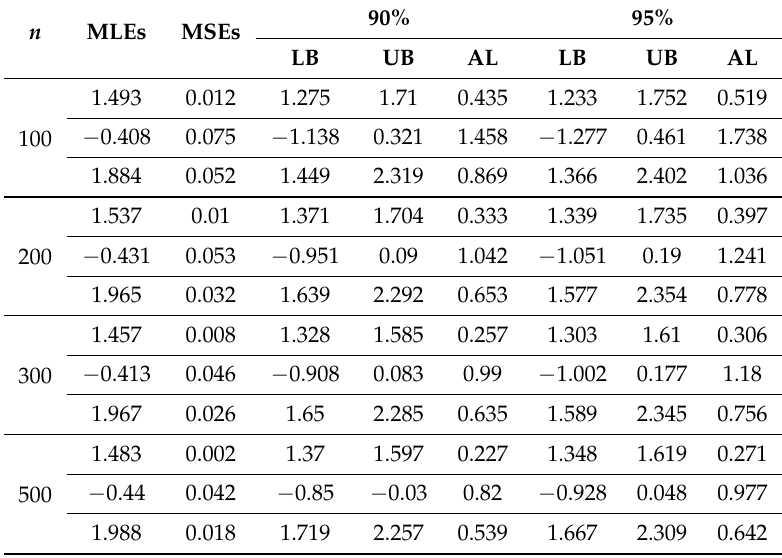
Table 3. Numerical measures of interest of the TOFrE model for Set1 (1.5, − 0.5, 2).